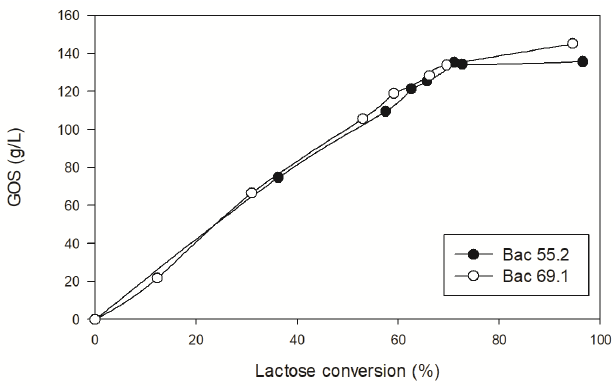
Figure 4. Galactooligosaccharide formation vs. lactose conversion by P. anthophila permeabilized cells.